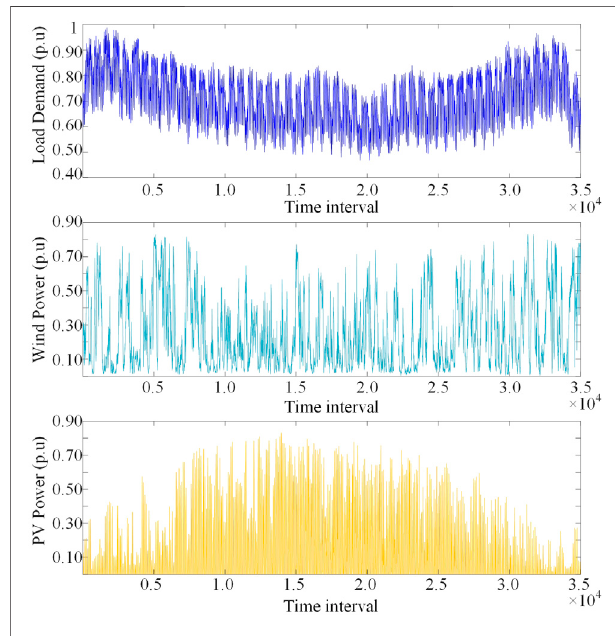
FIGURE 5 | Time series